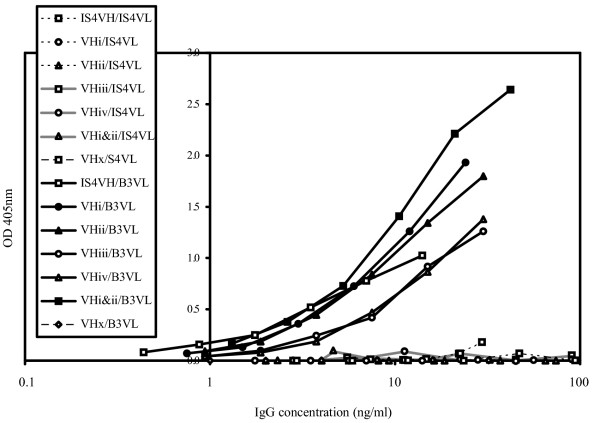
Effect of arginine to serine point mutations in IS4 variable heavy chainregion (VH) complementarity determining region 3. Cardiolipin binding of IgG in COS-7 cell supernatants containing wild-type or mutant forms of IS4 heavy chain expressed with wild-type B3 or IS4 light chains. The IS4VH mutants VHi, VHii, VHiii and VHiv contain single arginine to serine point mutations at positions 96, 97, 100 and 100 g, respectively; VHi&ii contains arginine to serine point mutations at positions 96 and 97; and VHx has an arginine to serine point mutation at all four positions. Presented as concentration of IgG in the supernatant versus optical density (OD) at 405 nm in the anti-cardiolipin ELISA.